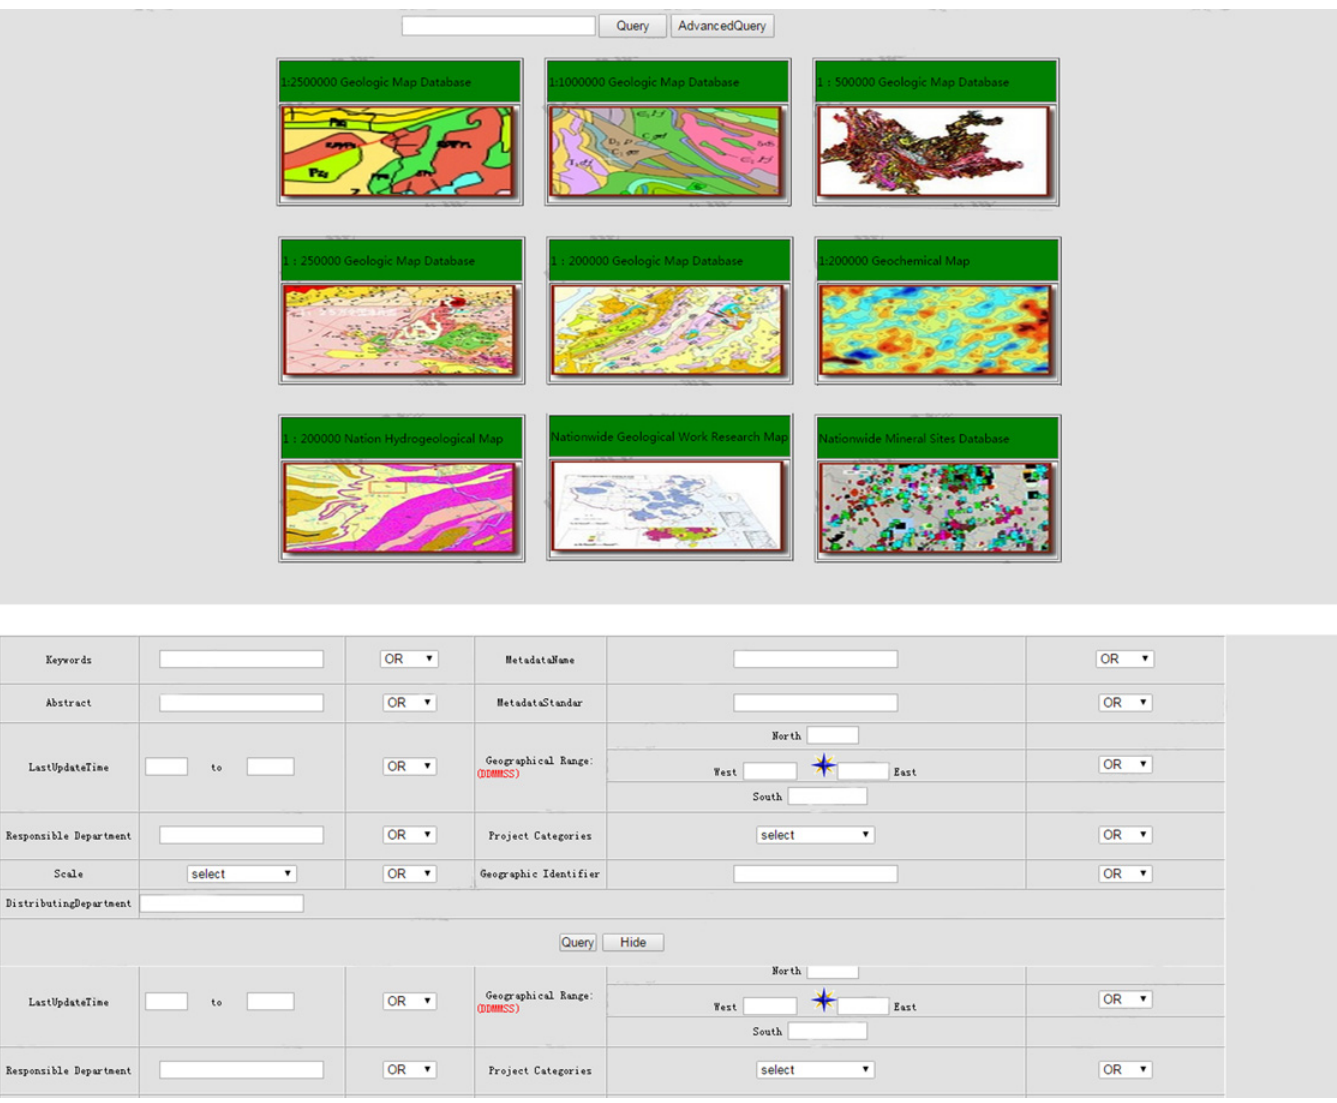
Fig 11. Multiple methods for metadata